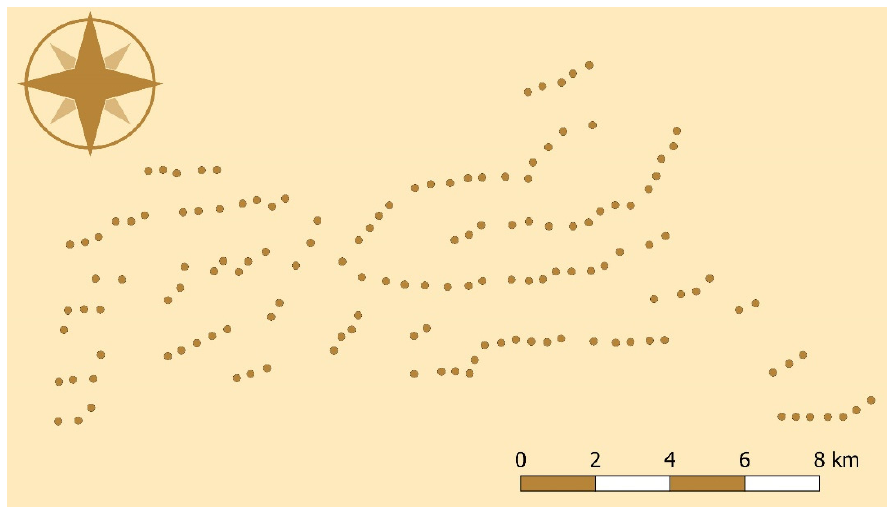
Figure 6. A wind farm with 144 wind turbines started operation in 2017–2019 in Texas.